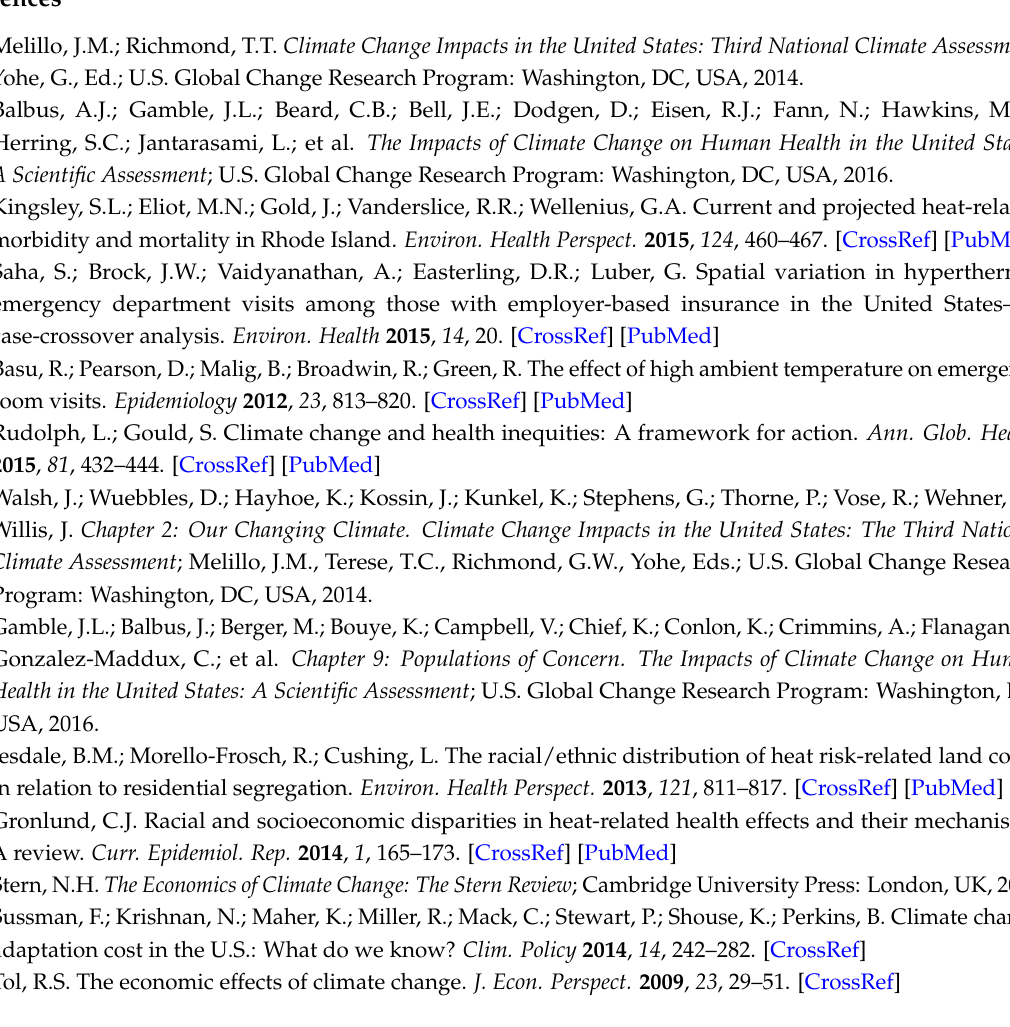
Table S1: Comparison of nationally adjusted mean costs per hospitalization for patients by race, stratified by gender 2001–2010